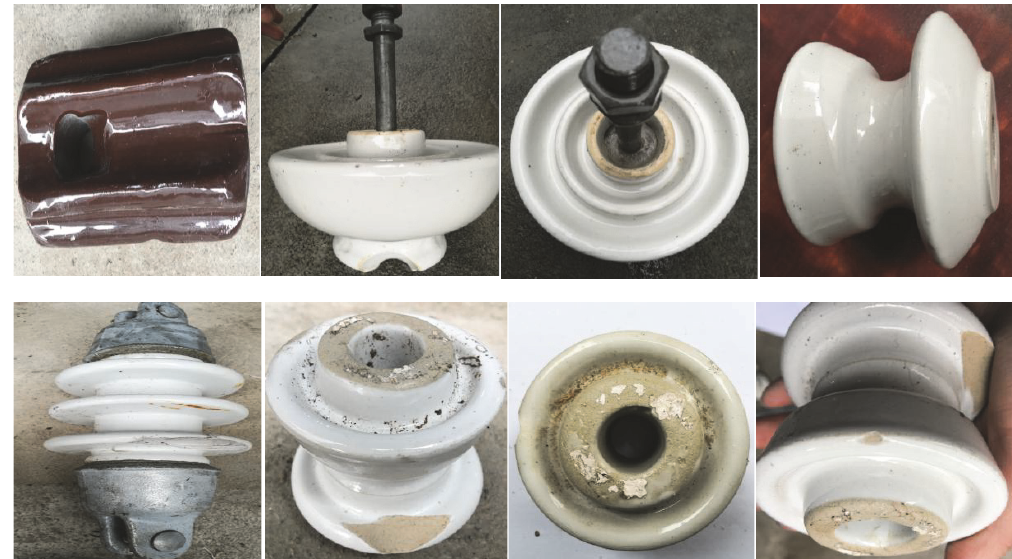
Figure 5: Some electrical insulator images in our